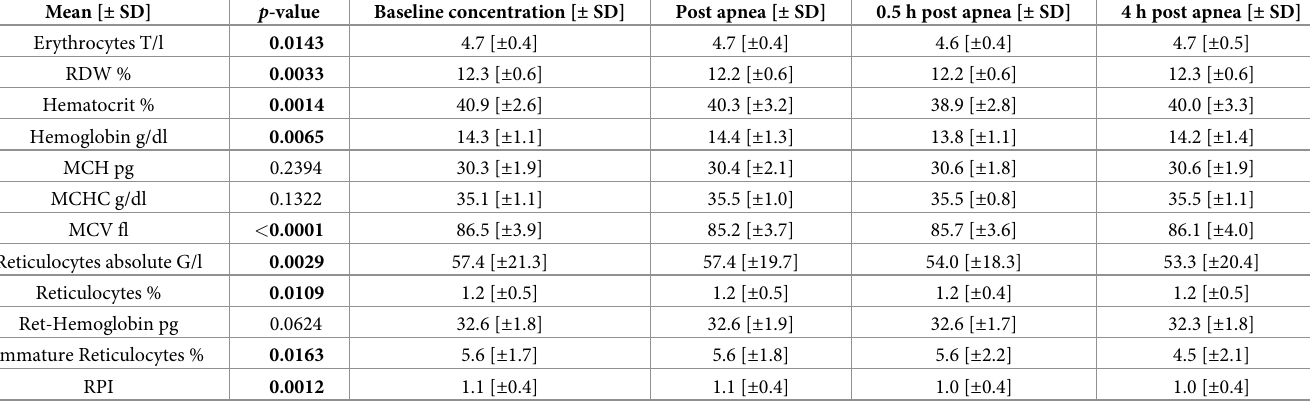
Table 1. Mean values, standard deviations and p -values at four different time points (baseline concentrations, immediately post apnea, 0.5 h and 4 h after apnea) of red blood cell parameters.